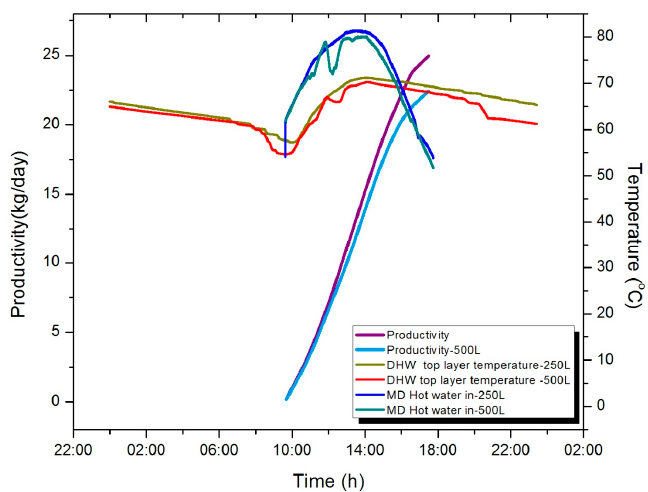
Figure 15. Performance variation of SCMD with two different DHW withdrawal rates.